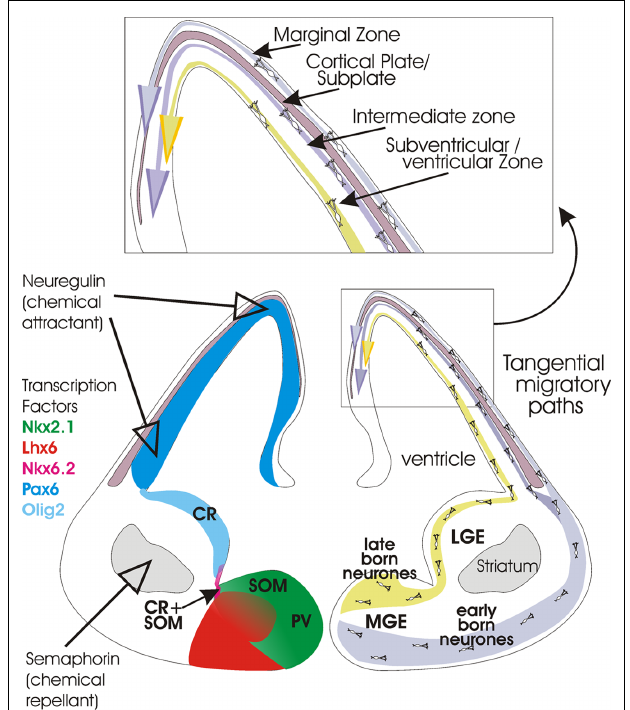
FIGURE 1 | Cartoon (lower right) summarizing the origins of cortical interneurons and the tangential migratory paths they follow to the developing neocortex (cortical plate and subplate at this stage of development). At first, early born interneurons follow a more ventral route before migrating along the marginal zone overlying the developing cortex. Once the cortical plate has developed, cells in this pathway also migrate along the intermediate zone. Later born neurones follow a more dorsal route and then migrate along the subventricular zone. See insert (top) for layers. On the left, expression patterns of some of the transcription factors that appear to play a role in differentiation and migration are indicated (see color key).The expression of two important extracellular signals, Semaphorin (3A and 3F) and Neuregulin-1 are also indicated.The birth places of somatostatin-containing (SOM), parvalbumin- containing (PV), calretinin- (CR), and calretinin- plus somatostatin-containing (CR + SOM) interneurons are also indicated. Coronal section through the brain of an embryonic mouse (approximately E14). Figure modified from Hernández-Miranda et al. (2010), Heng et al. (2007), Huang (2009b).